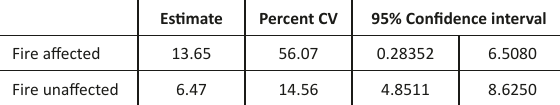
Table 7. Comparative densities of fire affected and unaffected